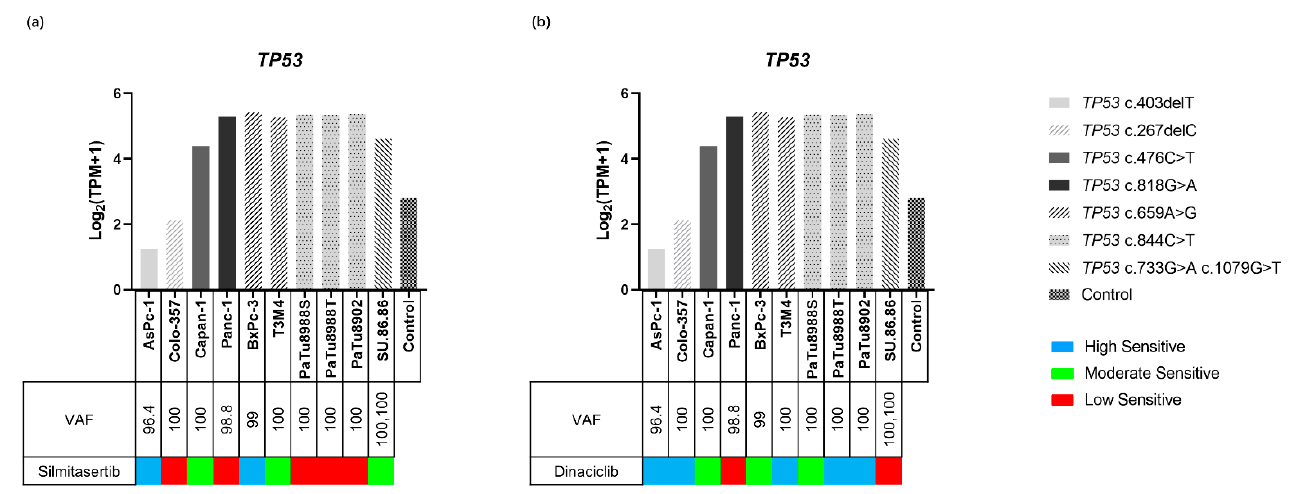
Figure 6. Gene expression of TP53 in ten PDAC cell lines and the control. The sensitivity to silmitasertib ( a ) and dinaciclib ( b ) as well as the variants of TP53 are indicated for each cell lines. Gene expression levels are displayed as Log 2 (TPM+1). Missense variants were associated with gene higher expression while frameshift variants were related to low gene expression.